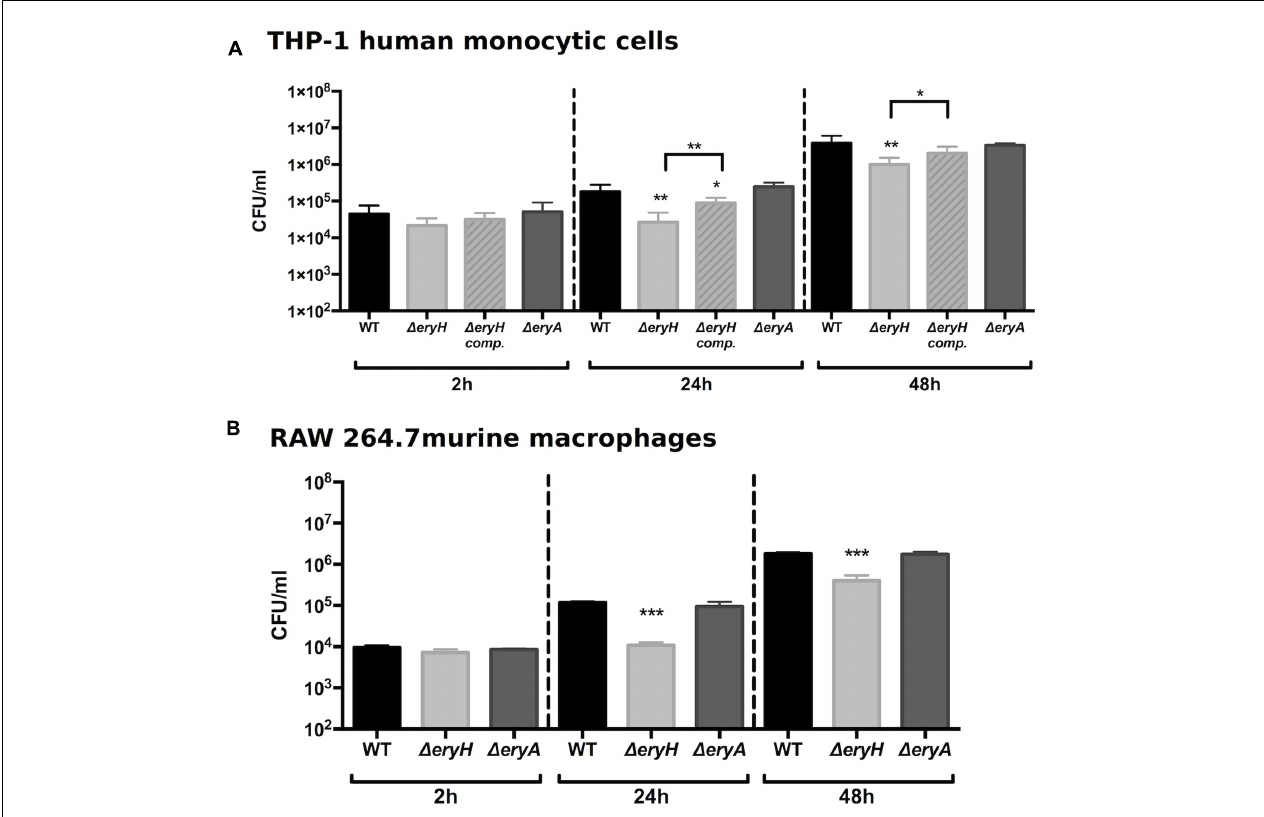
FIGURE 3 | Brucella abortus (cid:49) eryH but not B. abortus 2308 (cid:49) eryA or the complemented B. abortus (cid:49) eryH ( eryH comp.) are attenuated in human (A) and murine (B) macrophage-like cells. Values are the average plus the standard deviation of three experiments for THP-1 and of one representative replicate for RAW 264.7 ( ∗ p < 0.05; ∗∗ p < 0.01; ∗∗∗ p < 0.001 [Student’s t